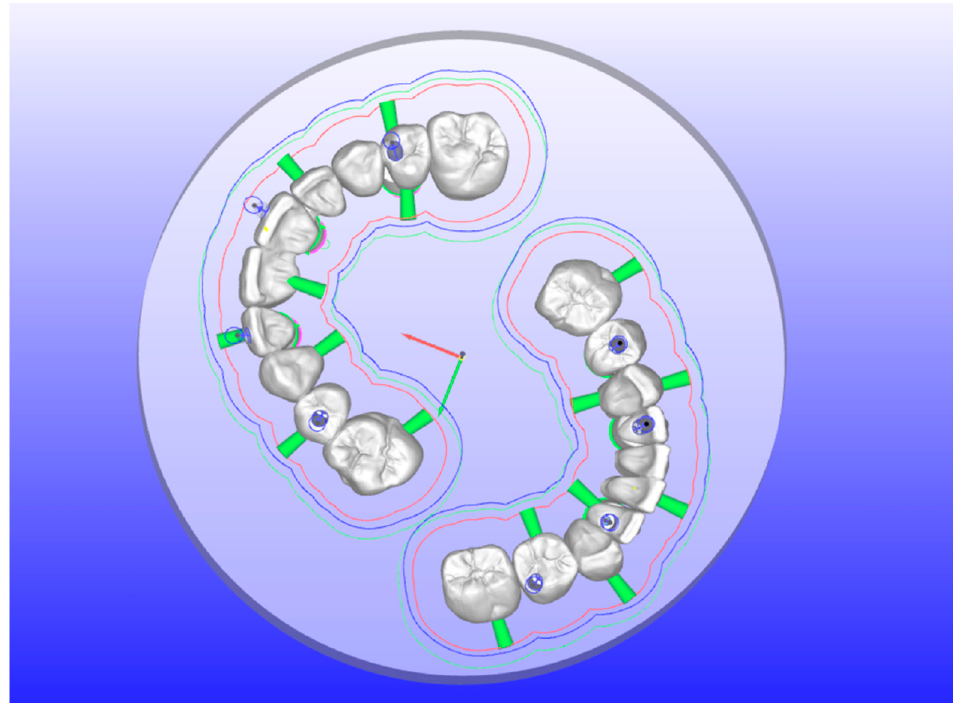
Figure 10. Interim restorations exported for computer aided machining (CAM) on hyperDENT ® software.